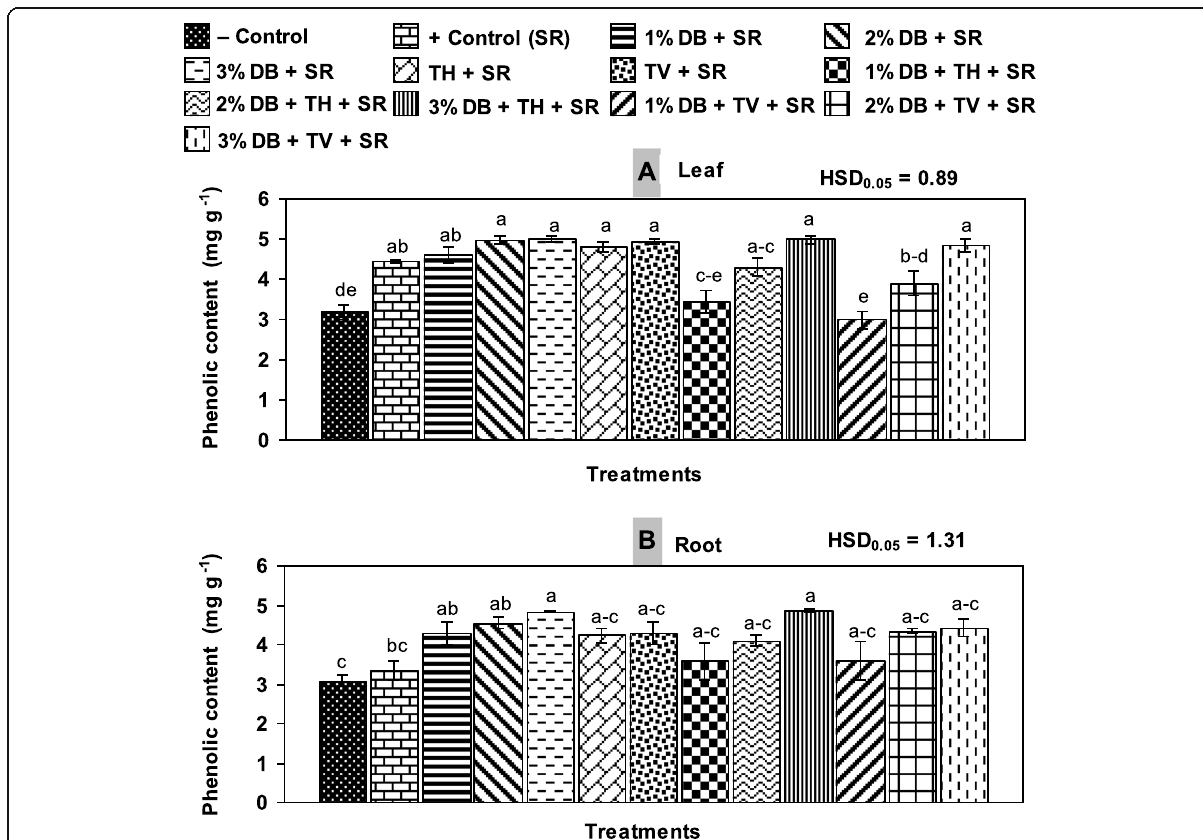
Fig. 5 Effect of Sclerotium rolfsii (SR), Trichoderma harzianum (TH), T. viride (TV), and dry biomass (DB) of Chenopodium album on leaf and root phenolic content of chickpea var. Noor 2009. Vertical bars show standard errors of means of five replicates. Values with different letters at their top show significant difference ( p ≤ 0.05) as determined by Tukey ’ s HSD